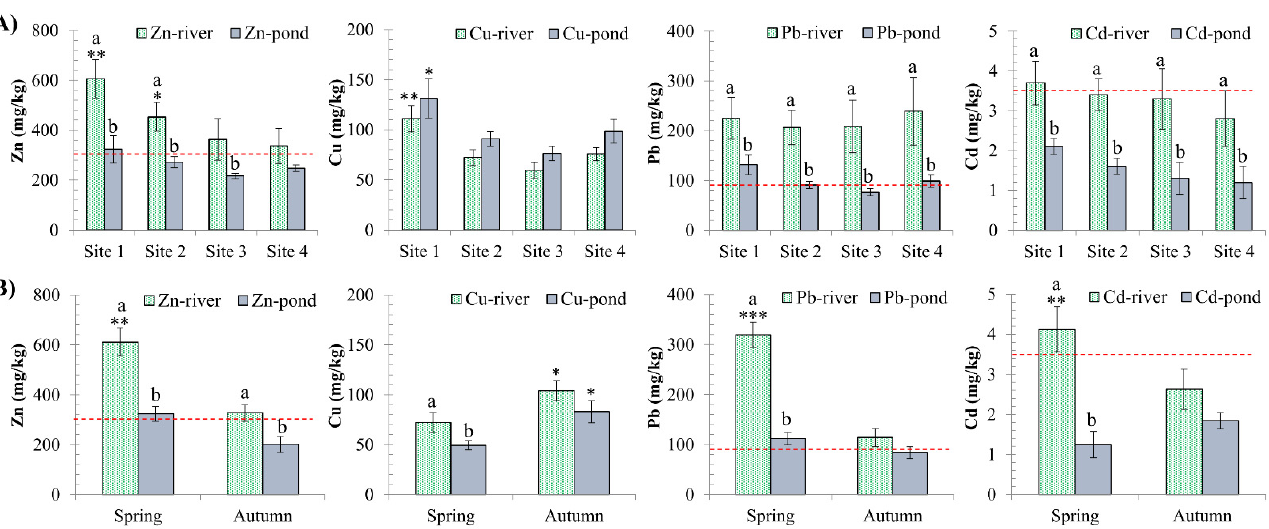
Figure 2. Spatial ( A ) and seasonal variations ( B ) of metals in sediment (mg/kg). Comparison with the Vietnamese standard Guideline for protecting aquatic life [39] (red dashed line). Significant differences between sampling sites ( A ) and times ( B ) in comparison to the lowest value (*) are indicated (mean ± SE, n = 10–20, * p < 0.05, ** p < 0.01, *** p < 0.001). Different letters (a > b) indicate that values from the ponds and the rivers at the same locations ( A ) or at the same times ( B ) are significantly different ( p < 0.05; ANOVA followed by Tukey–Kramer multiple comparisons